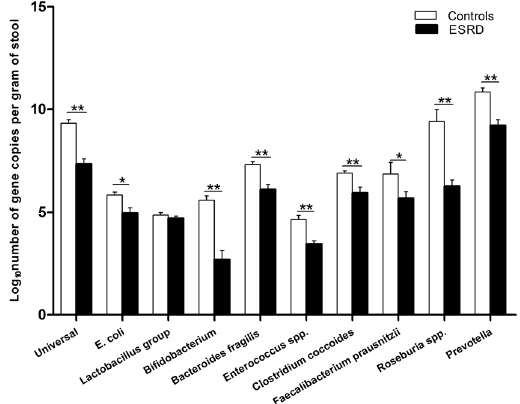
Figure 5. Bacterial groups quantified by qPCR expressed as log10 bacteria per gram of stool. qPCR for the common micropopulation in control subjects and ESRD patients. Black and white bars represent ESRD patients and healthy controls respectively. Independent-samples T Test was used to evaluate statistical difference between the two groups. * p < 0.05, ** p <